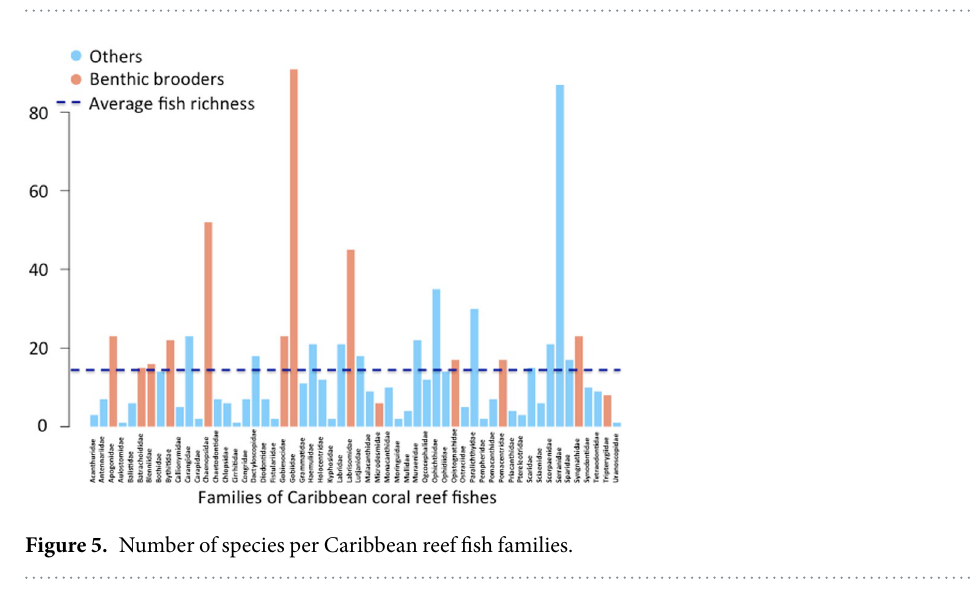
Figure 4. Phylogram of the inferred Opistognathus aurifrons population relationships. Scale bar shows 10 times the average standard error of the estimated entries in the sample covariance matrix. Arrows depict migration patterns. Red arrows represent stronger migration.